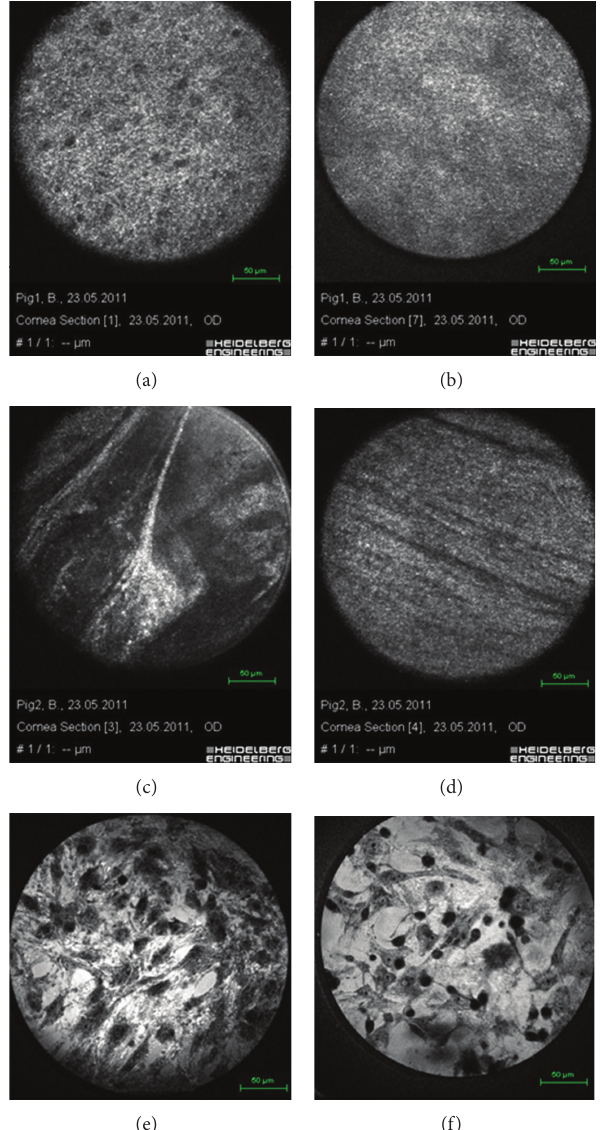
Figure 2: (a) Grey matter of the pig. (b) White matter of the pig. (c) Arachnoid membrane of the pig. (d) Ventricular wall of the pig. (e) Primary meningioma cell culture. (f) Primary glioblastoma cell